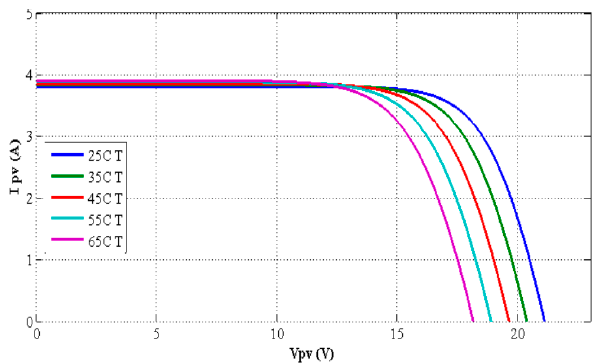
Figure 20. I vs. V Characteristics for varying temperature.